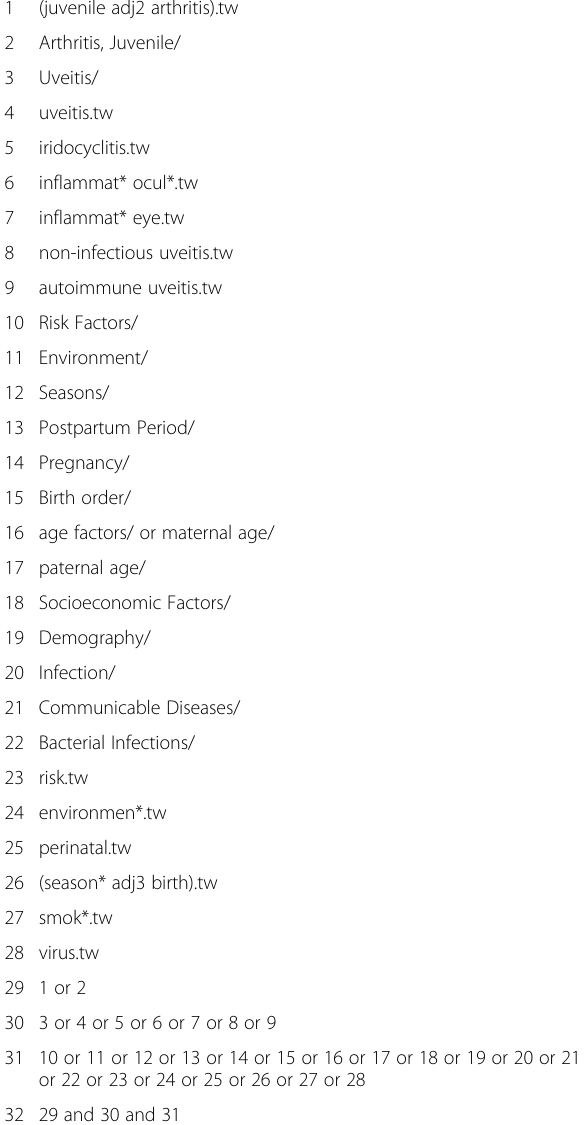
Table 1 Search strategy for MEDLINE by OVID (syntax amended for use in other